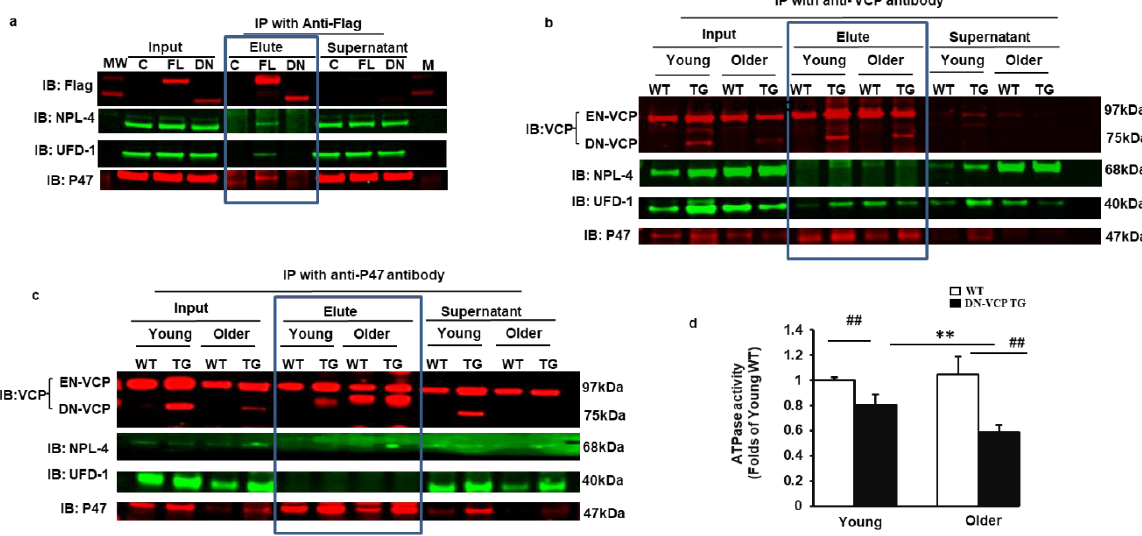
Figure 5. DN-VCP disrupts the VCP-cofactor interaction and leads to a binding preference of EN-VCP with the repressive protein P47. ( a ). Immonuoparticipation (IP) with anti-Flag and the Western blotting with the antibodies against the corresponding proteins in the cells overexpressed full-length VCP (FL-VCP) and dominant-negative VCP (DN-VCP) compared to the vector control. C: control plasmid with vector; FL: overexpressed full-length VCP, DN overexpressed DN-VCP; M: Molecular weight marker; ( b , c ). The representative images of the Western blots with the antibodies against the corresponding proteins after IP in cytoplasmic fractions of mouse heart tissues with anti-VCP ( b ) or anti-P47 ( c ). Input proteins were used as positive control and the supernatants of the IP were used as the negative control; ( d ). ATPase activity in DN-VCP TG and WT mouse heart tissues at young and older ages. **, p ≤ 0.01 vs. corresponding young mice, ##, p ≤ 0.01 vs age-matched WT mice.